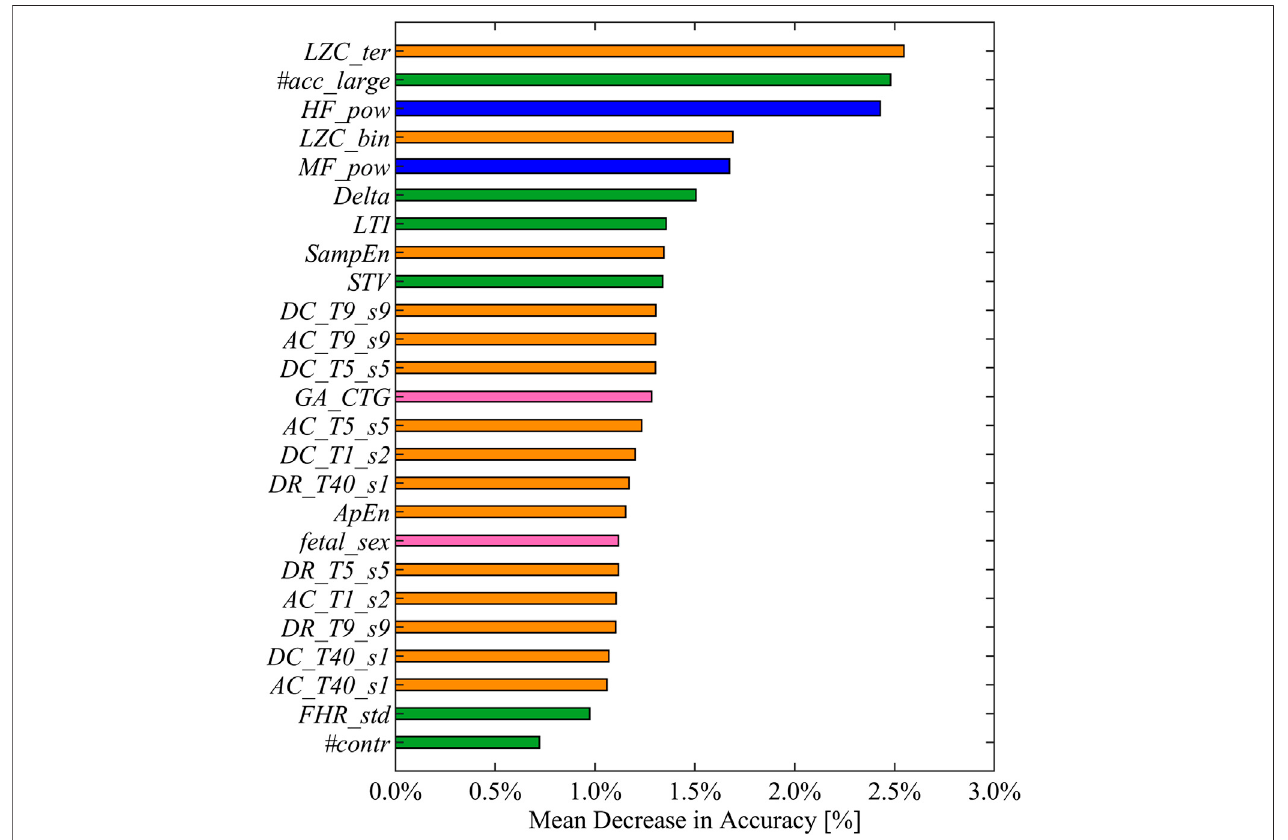
FIGURE 3 | Feature ranked by mean decrease in accuracy in descending order from top to bottom. Mean decreases in accuracy computed as the difference betweentheoptimalaccuracy(obtainedbyincludingtheentiresetofselectedfeaturesinthetrainingset)andthemodelslearnedexcludingeachfeaturealternatively.The displayed colors code for the different feature domains: green for MTd , blue for Fd , orange for Cd , and pink for FMd .